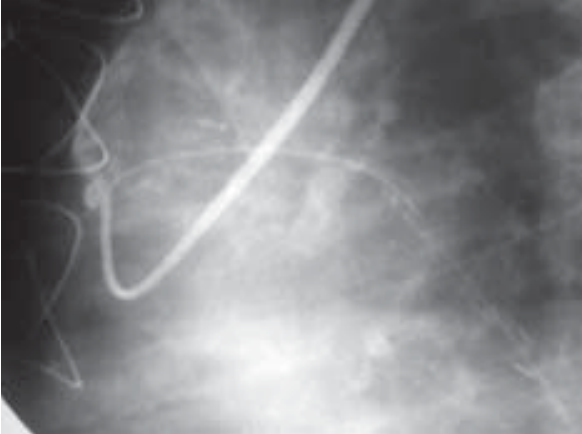
Fig. 4a - early restudy - 14 days after myocardial revascularization